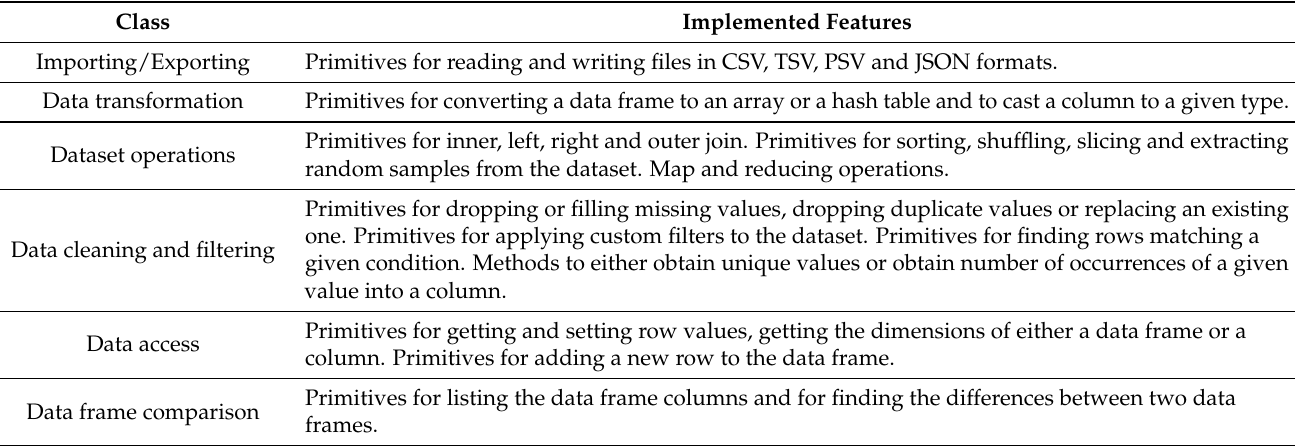
Table 5. Framework support for data analysis and data